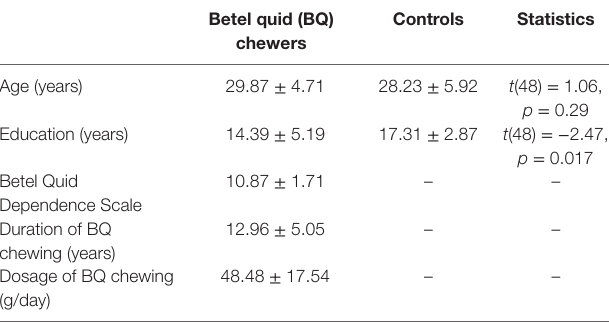
TaBle 1 | Demographic and clinical characteristics of participants (M ±